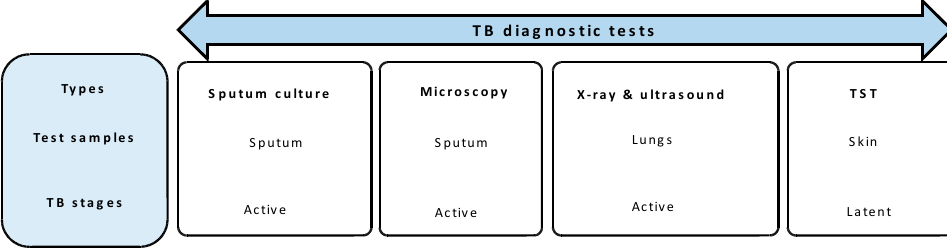
Figure 2. Widely used clinical TB diagnostic tests.